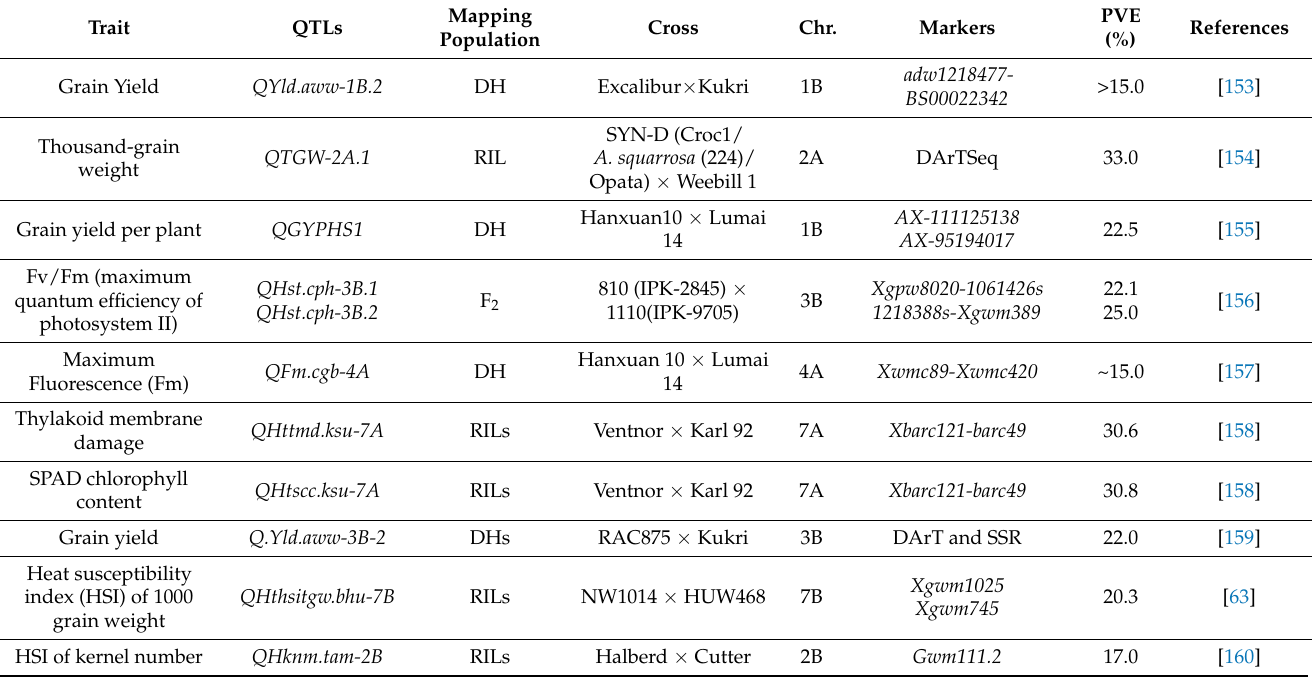
Table 4. List of recently mapped major QTLs for heat stress resistance in